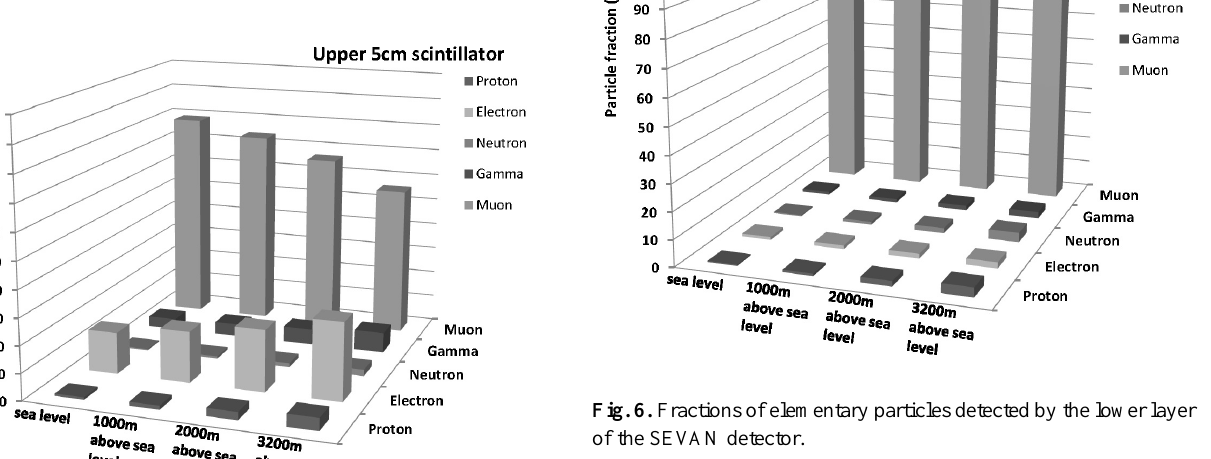
Fig. 3. The basic detecting unit of the SEVAN network.